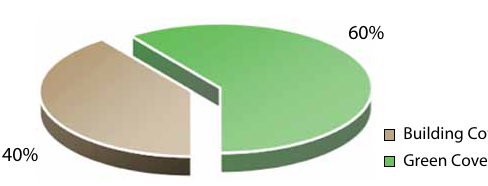
fig. 11. urban Development Parameters